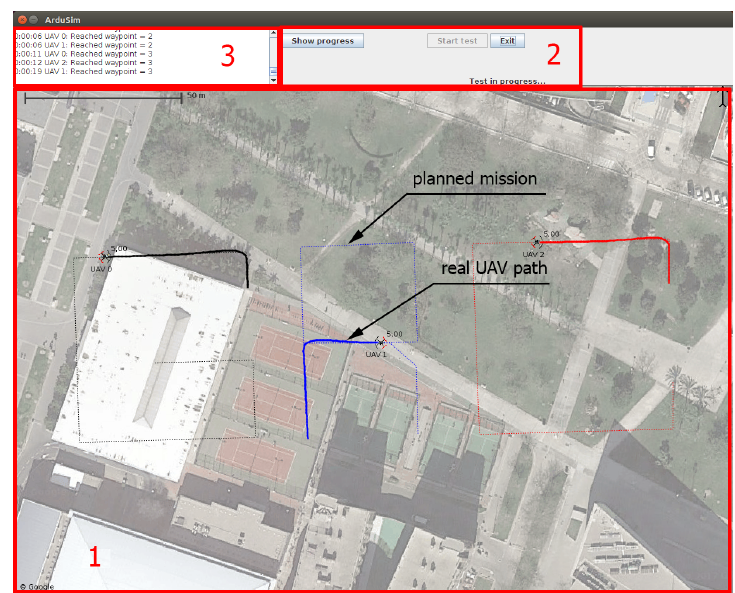
Figure 1. ArduSim main interface: Three Unmanned Aerial Vehicles (UAVs) following a